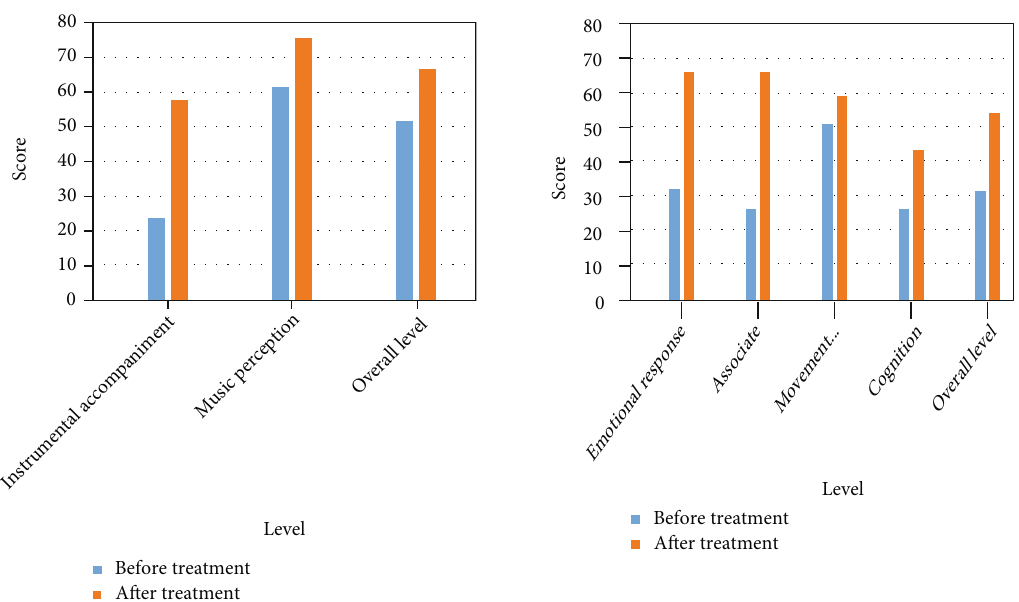
Figure 7: The emotional and behavioral performance of Xiao Y ’ s musical performance ability before and after music